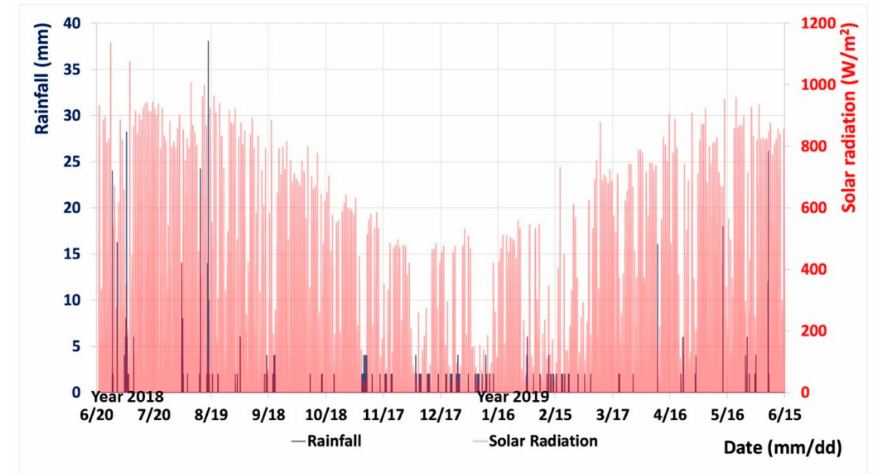
Figure 9. Solar radiation and rainfall of Nanjing from June 2018 to June 2019, (source: weather station in Southeast University, Nanjing, China).